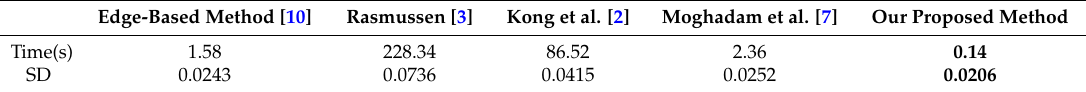
Table 3. Run-Time Comparison for Vanishing Point